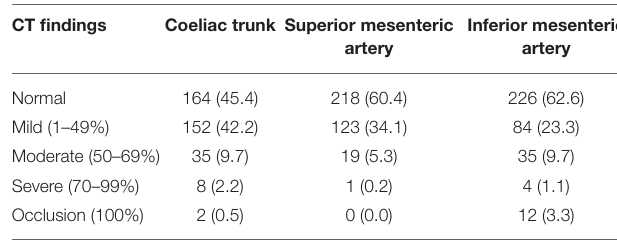
TABLE 2 | Repartition of patients by degree of stenosis for each